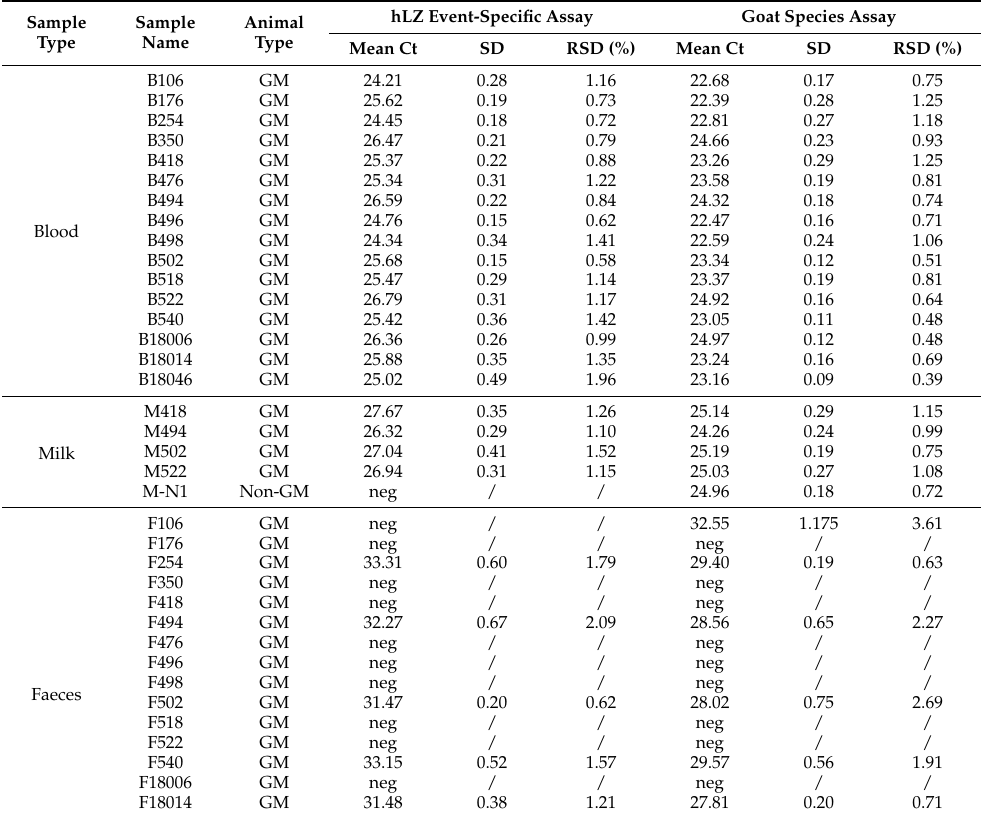
Table 4. Detection of practical blood, milk, faecal and soil samples using the developed event-specific real-time PCR